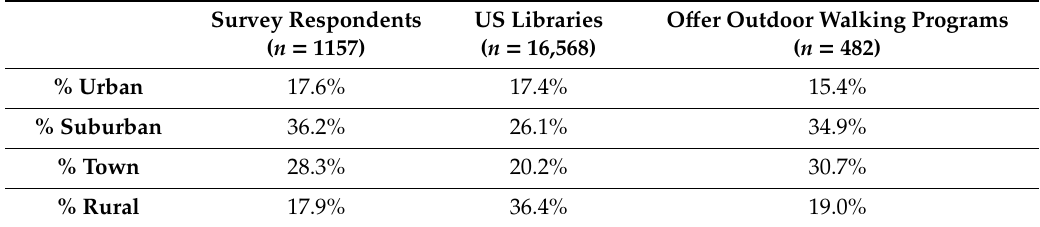
Table 1. Urban-rural classification of respondents, compared to break-down of public libraries in the United States. Source: [20]. Note: Comparable data from Canada is unavailable, see [19].